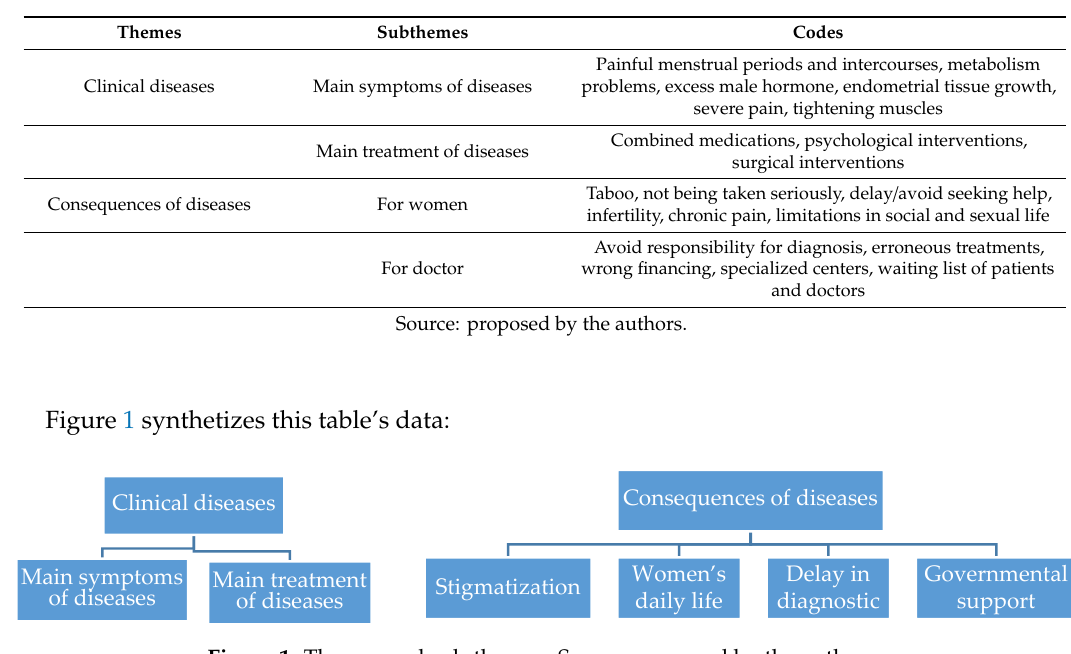
Figure 1. Themes and sub-themes. Source: prepared by the authors.